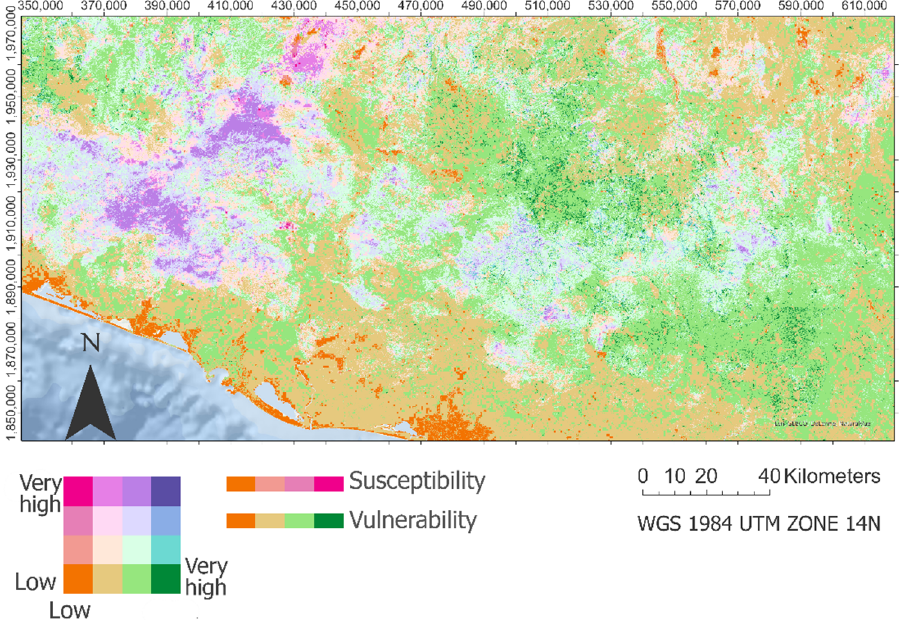
Figure 6. Landslide risk assessment. Includes the estimation of landslide susceptibility and landslide vulnerability.